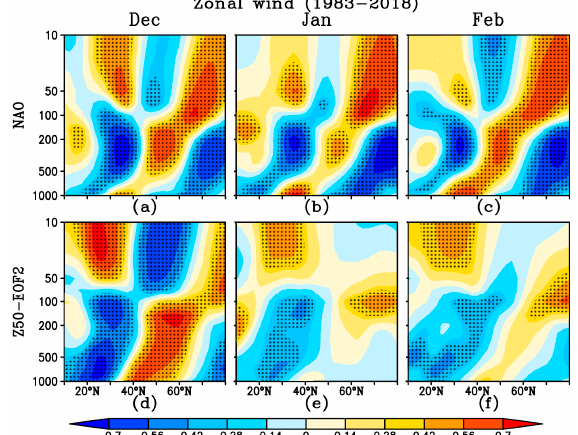
Figure 9. TCCs of zonal-mean wind with the observed NAO ( a – c ), and the PC2 of Z50 ( d – f ) in December ( a , d ), January ( b , e ), and February ( c , f ) during the period 1983–2018. Dotted areas indicate statistical significance at the 95% confidence level, as estimated by a local Student’s t- test.